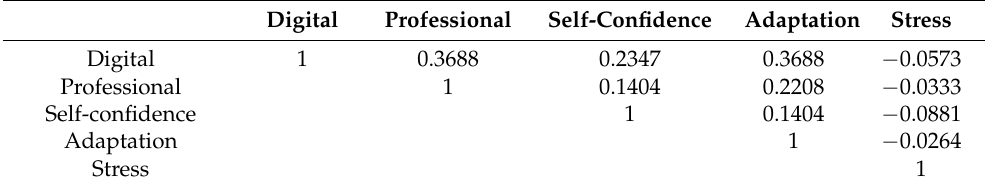
Table 11. Pearson’s correlation coefficients of the different subscales of the survey within digital native professors.